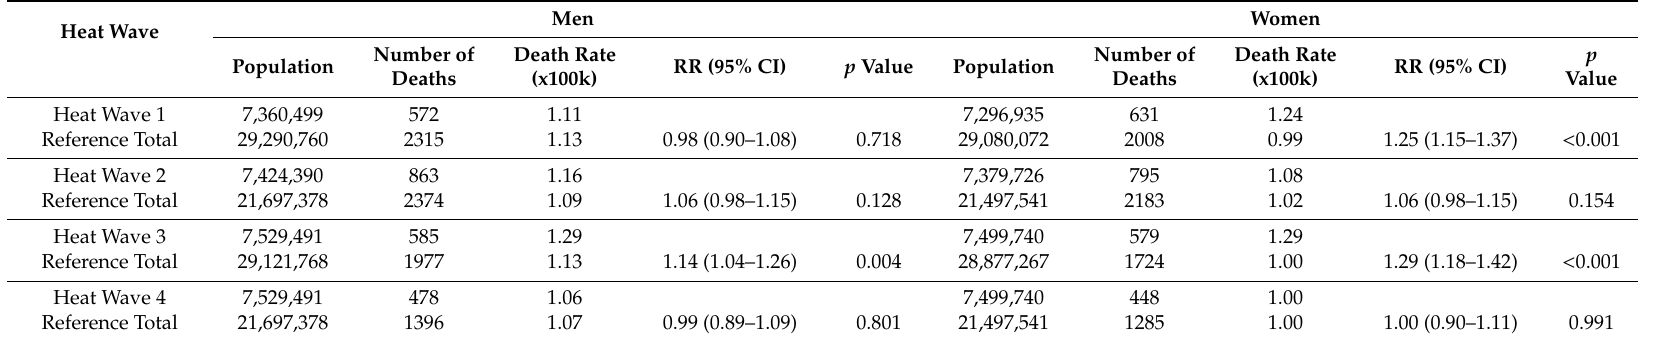
Table 3. Sex-specific Death Rates and Risk Ratios of the Extreme Heat Waves between 2013 and 2017.